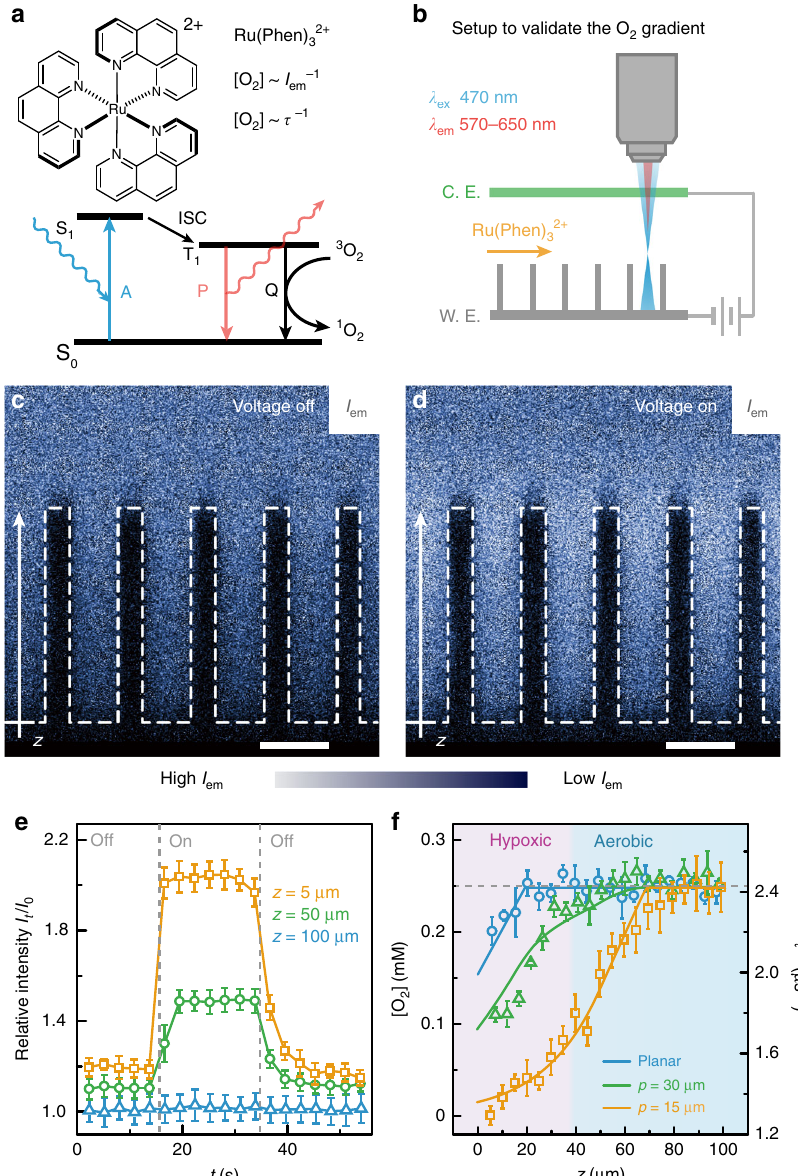
Fig. 2 Experimental validation of microscopic O 2 gradient in microwire array. a Simpli fi ed Jablonski diagram of Ru(phen) 3 2 + including the absorption (A), intersystem crossing (ISC), phosphorescence (P), and the quenching (Q) of its triplet excited states by O 2 . I em and τ denote the intensity and lifetime of phosphorescence emission, respectively. b Electrochemical setup under a confocal microscope that in situ maps O 2 gradient. WE denotes microwire array working electrode and CE denotes counter electrode. The setup is mounted on an inverted microscope so the wire array is facing down during observation (as shown in Supplementary Fig. 4). c , d Cross-sectional I em pro fi les in wire array in the absence and presence of E appl , respectively. Dashed lines depict wire morphology. Blue pseudo-colored. Scale bars, 15 μ m. e The temporal response of relative intensities I em ( I t / I 0 ) at different z values within wire array. E t = 15 and 35 s, respectively ( n = 3). f Simulated (lines) and experimentally determined (points, n = 3) [O appl was switched on and off at different electrode geometries. Unless speci fi ed, all results, as well as the suggested hypoxic (pink) and aerobic (blue) areas, refer to the geometry shown in Fig. 1c under E appl = 0.5 V vs. RHE. Error bars = standard deviation ( n = device, an indicator of biological N 2 fi xation, were 5.7 ± 2.3 × 10 2 and 1.9 ± 0.7 × 10 2 mg L − 1 for X. autotrophicus and B. japonicum strains, respectively; the changes of total organic carbon ( Δ TOC), another indicator of microbial biomass accumulation, were 2.5 ±